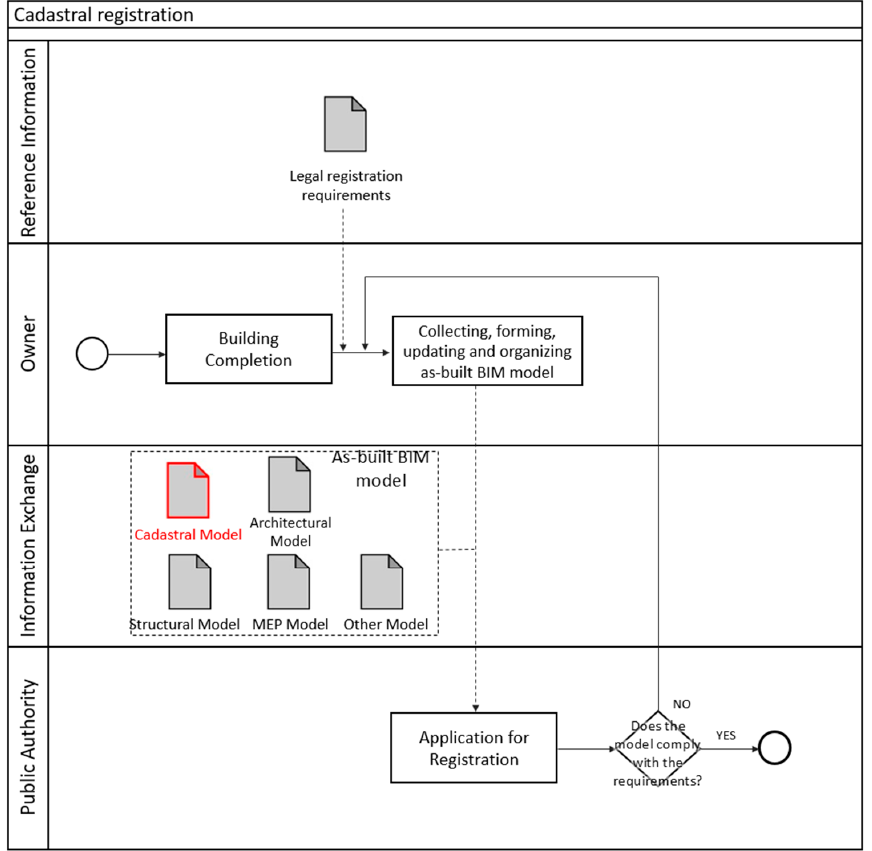
Figure 2. Process of handover of the as-built design to a public authority.